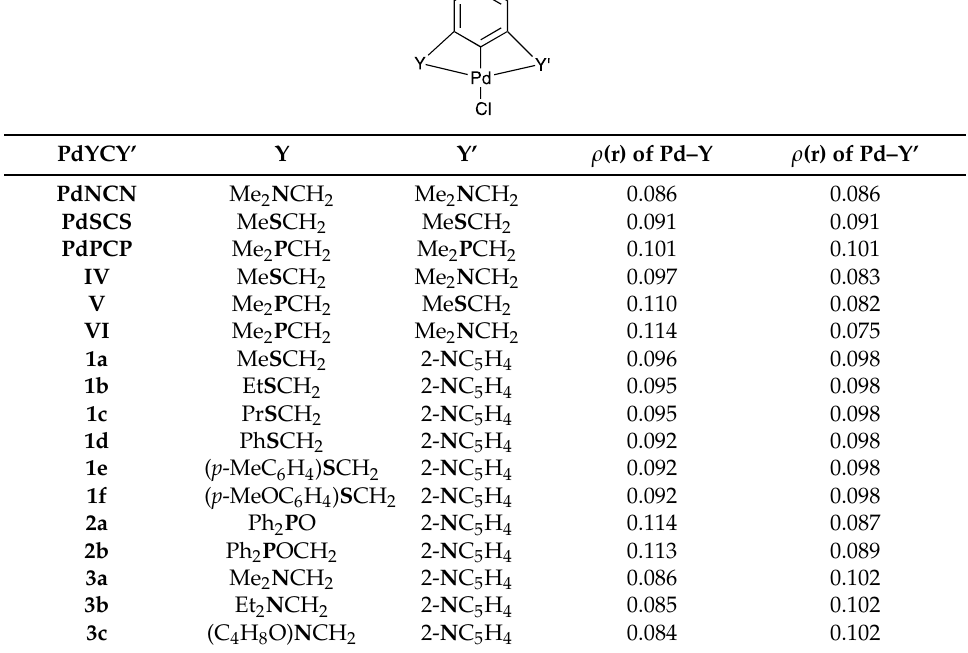
Figure 4. Symmetrical NCN, SCS, and PCP pincer palladacycles ( PdNCN , PdSCS and PdPCP ) [36] and model unsymmetrical SCN ( IV ), PCS ( V ), and PCN ( VI ) pincer palladacycles. Table 3. Electron density ρ ( r ) in symmetrical and unsymmetrical pincer palladacycles (values are in atomic units). The donor atom is shown in bold for each side arm, Y and Y’.